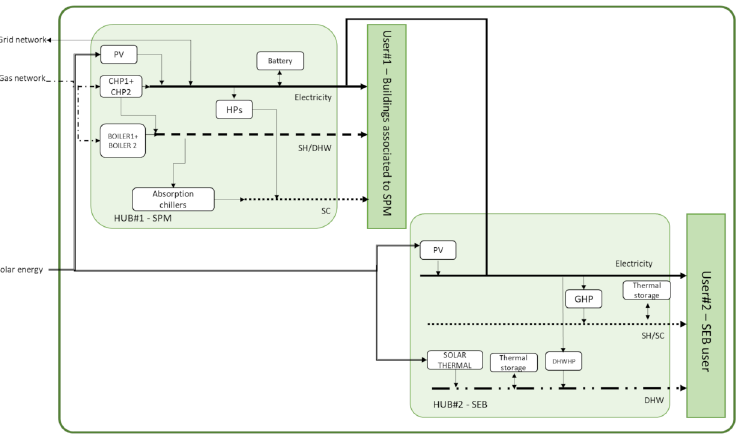
Figure 2. SPM and SEB representation in ILEC context.